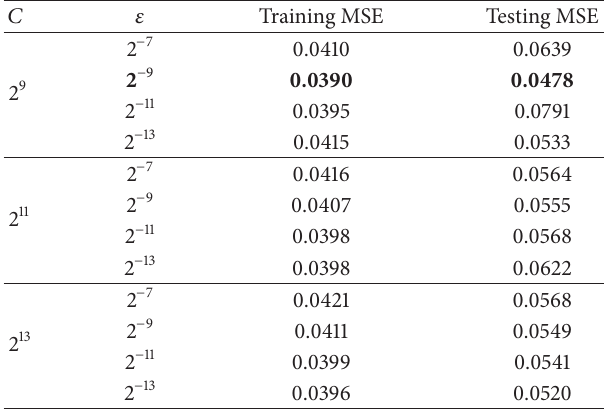
Table 2: Model selection results of the tICA-SVR model.